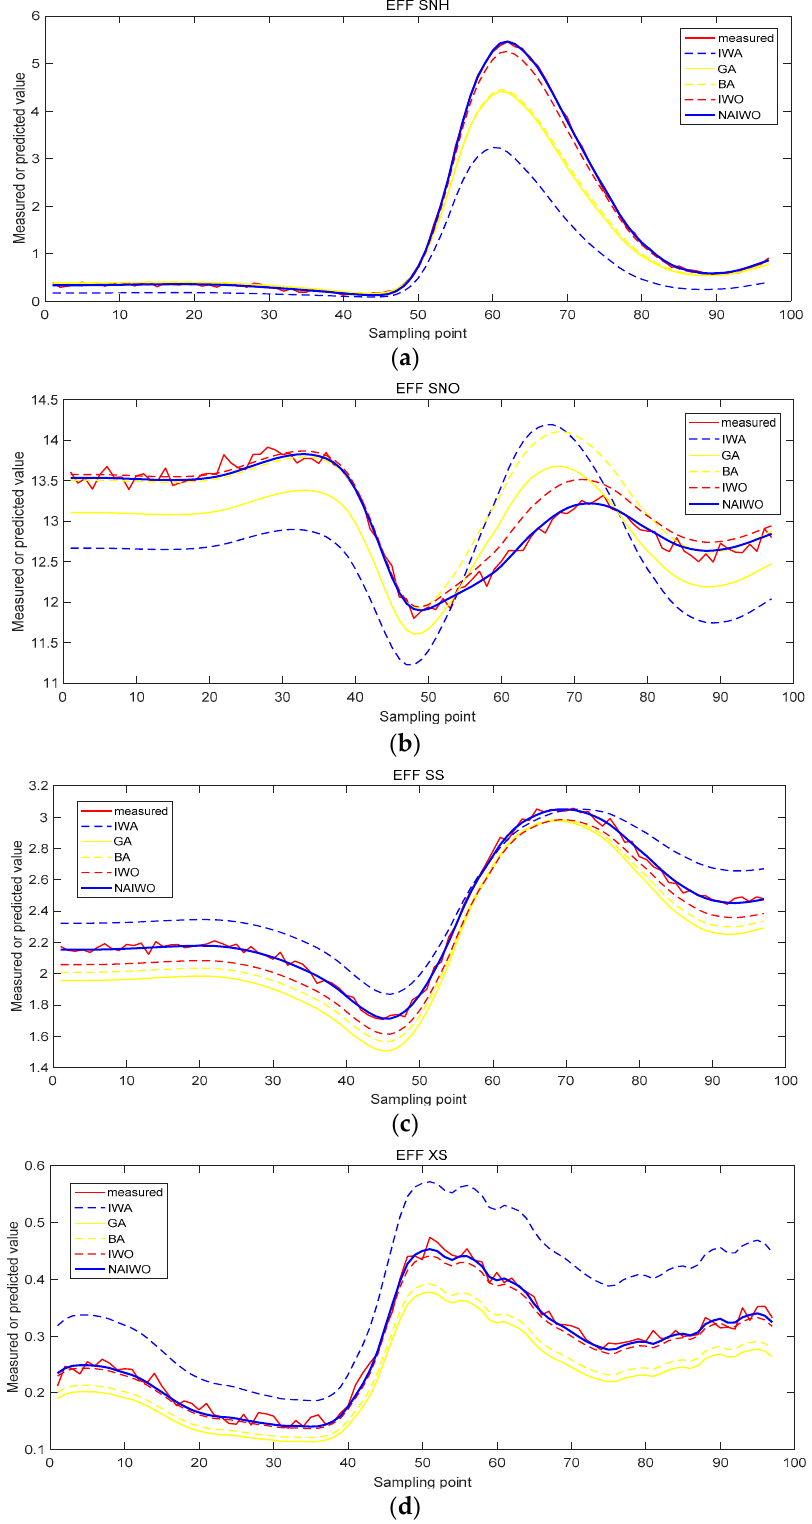
Figure 5. Comparison of predicted and measured values of effluent water quality parameters for ( a ) Ammonia nitrogen ( S NH ), ( b ) nitrate nitrogen ( S NO ), ( c ) soluble rapidly biodegradable organic matter ( S S ), and ( d ) insoluble slowly degradable organic matter ( X S ) in PC-WWTP.